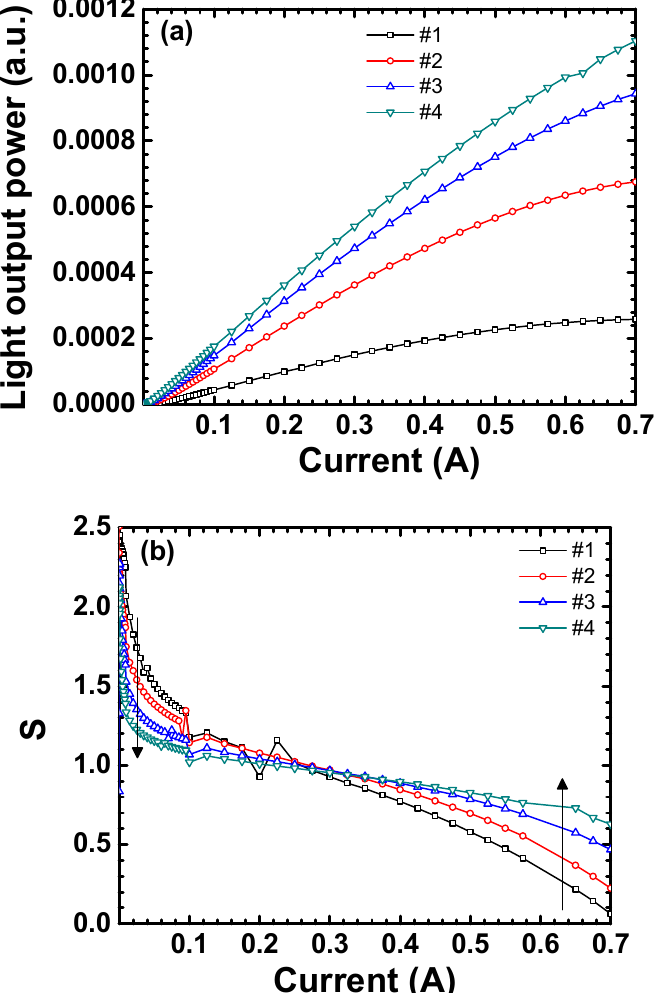
Figure 4. ( a ) Light power vs. current ( L - I ) characteristics and ( b ) S values calculated from the measured L - I characteristics for all samples, where #1 suffers from severe overflow of electrons owing to the low band offset.